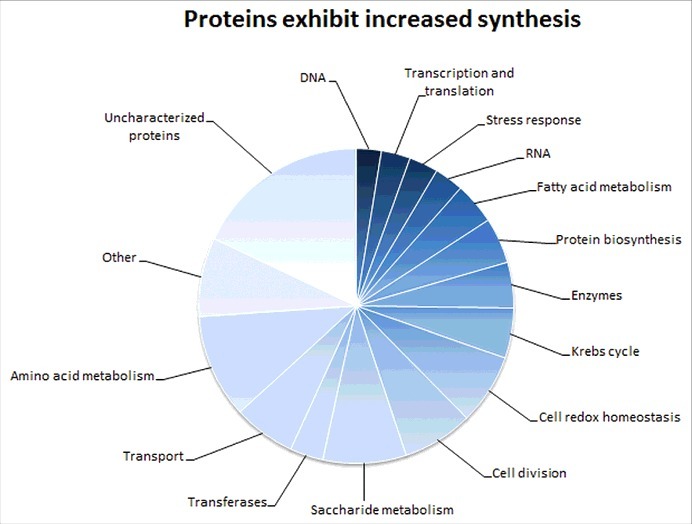
Proteins exhibiting increased synthesis. Diagram shows groups of proteins with increased synthesis in hupB null mutant that were detected in iTRAQ analysis. The number of these proteins is indicated in the brackets. Associated with: Amino acid metabolism (25), transport (23), saccharide metabolism (20), cell division (17), cell redox homeostasis (17), Krebs cycle (12), enzymes (11), protein biosynthesis (11), fatty acid metabolism (10), RNA (7), stress response (7), transcription and translation (7), DNA (6), lipid metabolism (3) and other [pyrimidine and purine biosynthesis (5), nucleotide metabolism (7), antibiotic response (1), capsule and LPS (2), cyanophycin (2), terpenoid (2), vitamin biosynthesis (3), iron and nitrogen (4)].